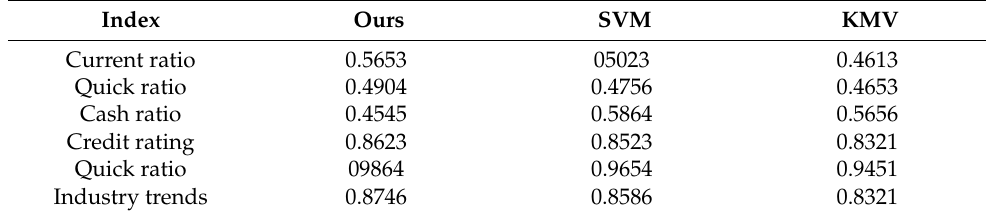
Table 4. Prediction accuracy of different metrics.